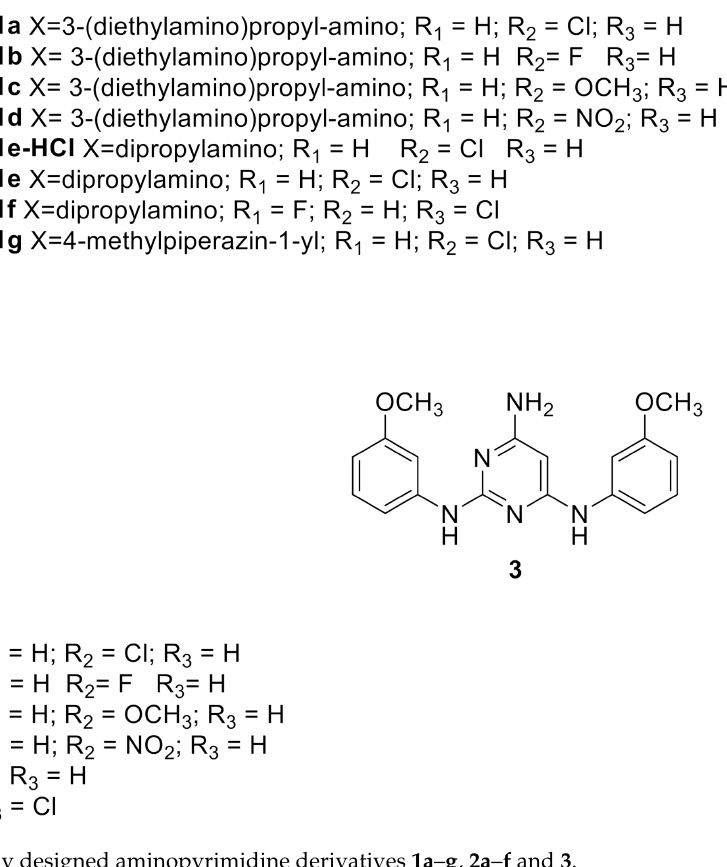
Figure 2. Structures of the newly designed aminopyrimidine derivatives 1a – g , 2a – f and 3